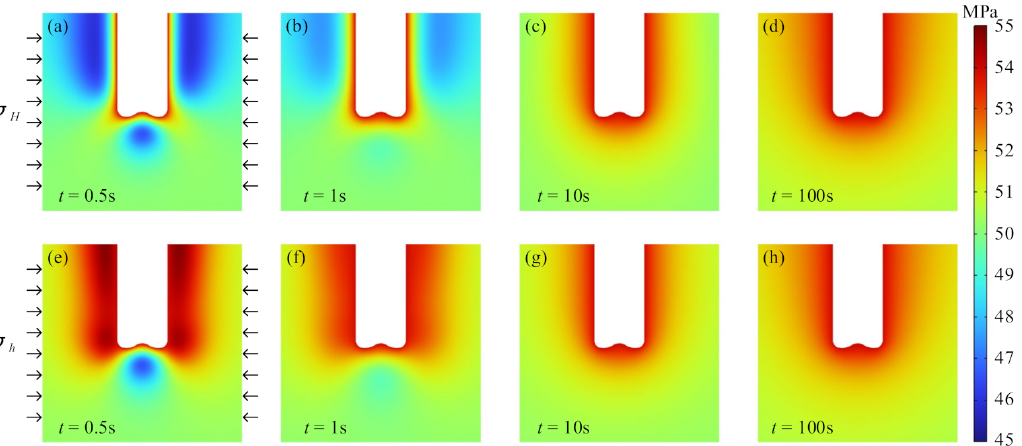
Figure 5. Formation pressure around the wellbore after drilling. ( a ) t = 0.5 s; ( b ) t = 1 s; ( c ) t = 10 s;